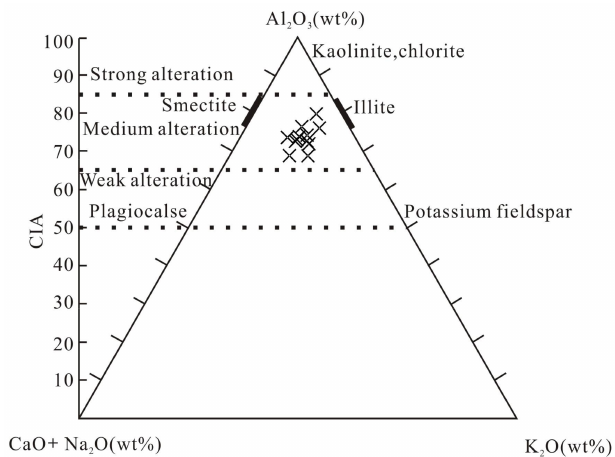
Figure 7. Ternary diagram of chemical alteration (the base map is from Li et al.